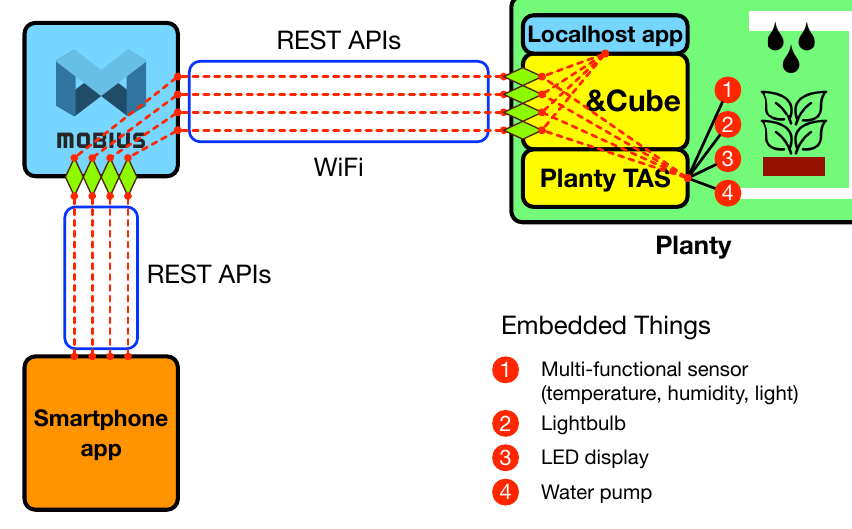
Figure 10. System architecture for Planty service